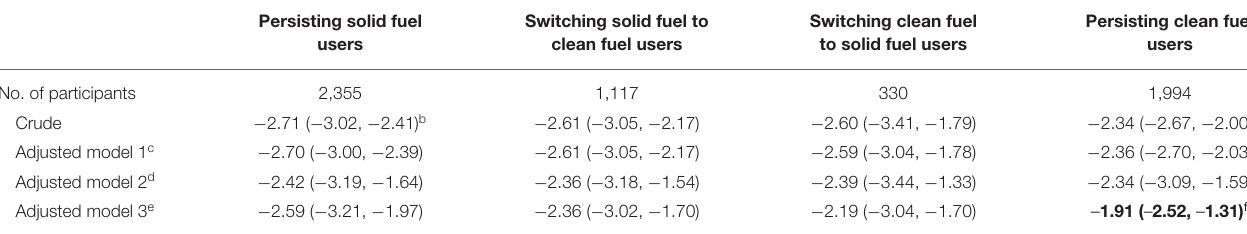
TABLE 2 | Association between switching types of fuel for cooking during the follow-up and changes of HGS a* .